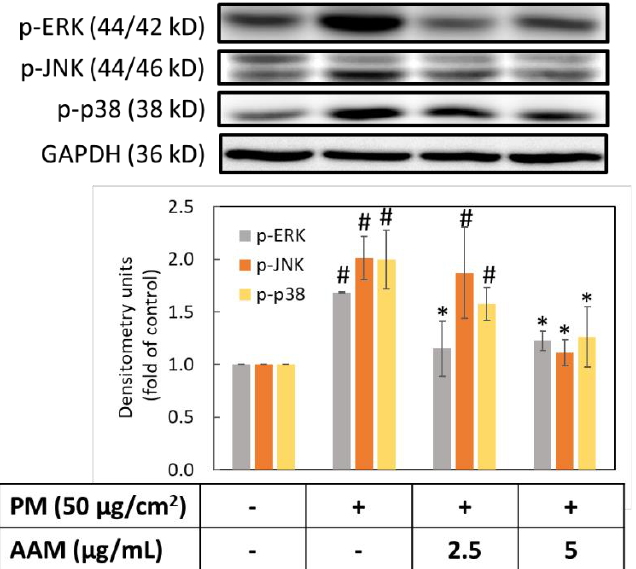
Figure 5. Effect of AAM on PM-induced phosphorylation of MAPK proteins in HaCaT cells. Data were from three independent experiments. Value are mean ± SD ( n = 3). # Significantly different from control group ( p < 0.05); * Significantly different from PM-induced group ( p < 0.05).